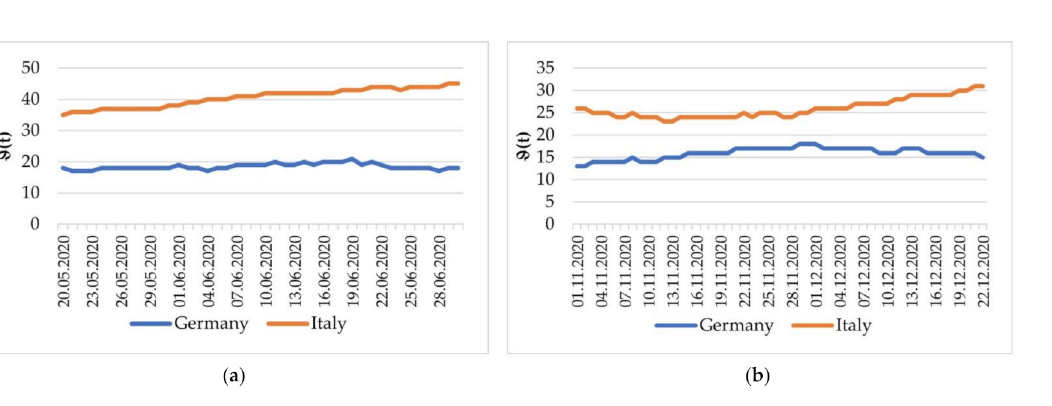
Figure 10. Dynamics of changes in the values of ϑ ( t ) in Germany and Italy ( a ) from May to June